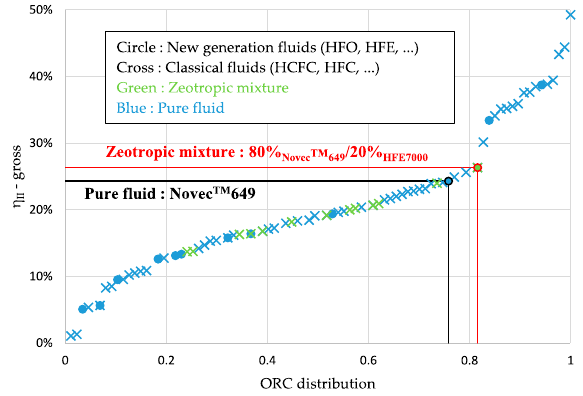
Figure 9. The ORCs’ distribution according to their gross thermal efficiency. 409